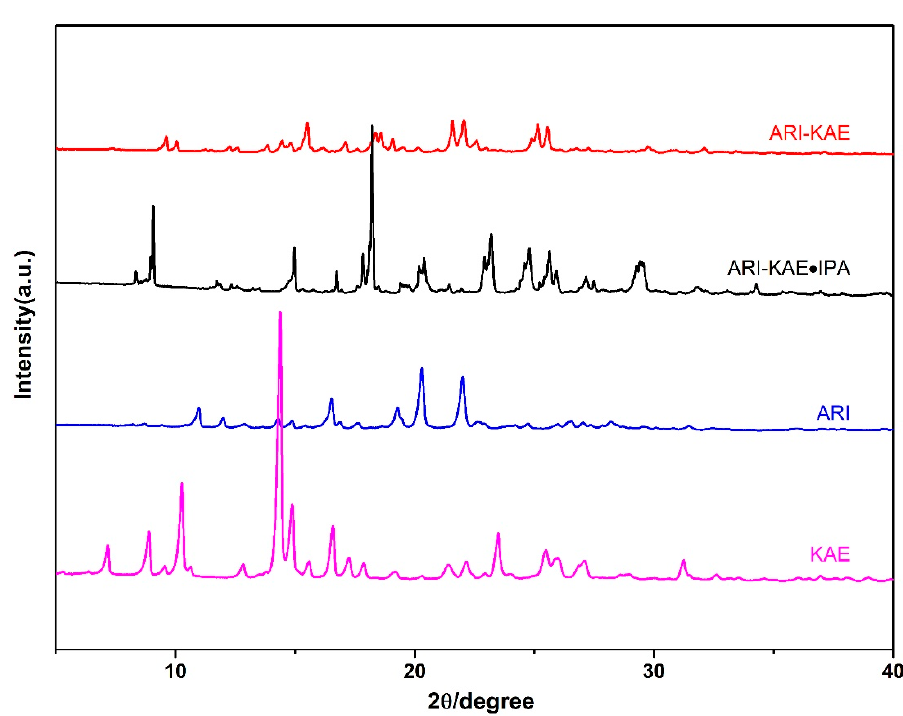
Figure 6. The PXRD pattern if ARI and KAE cocrystals.